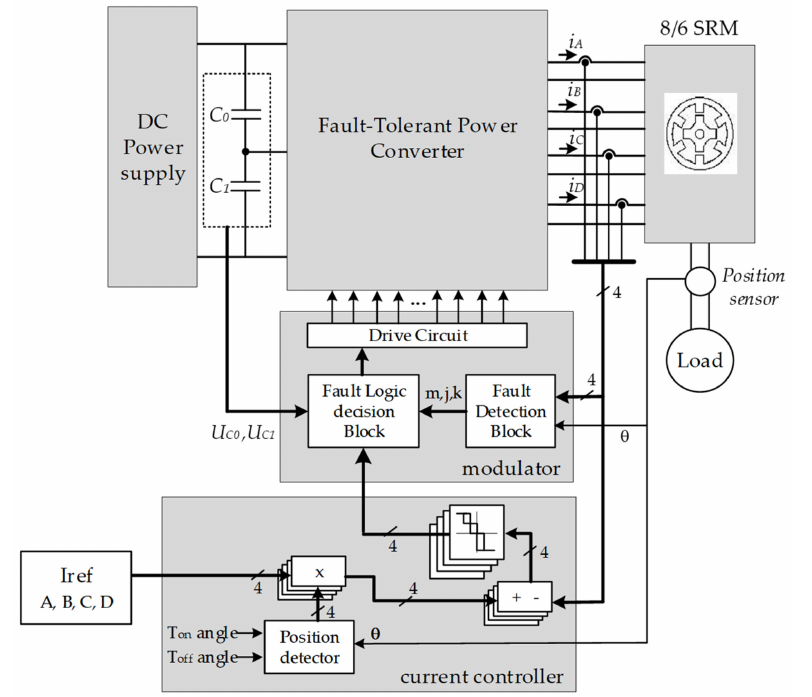
Figure 8. Detailed block diagram of the SRM speed controller (where the fault-tolerant power converter is the topology presented in Figure